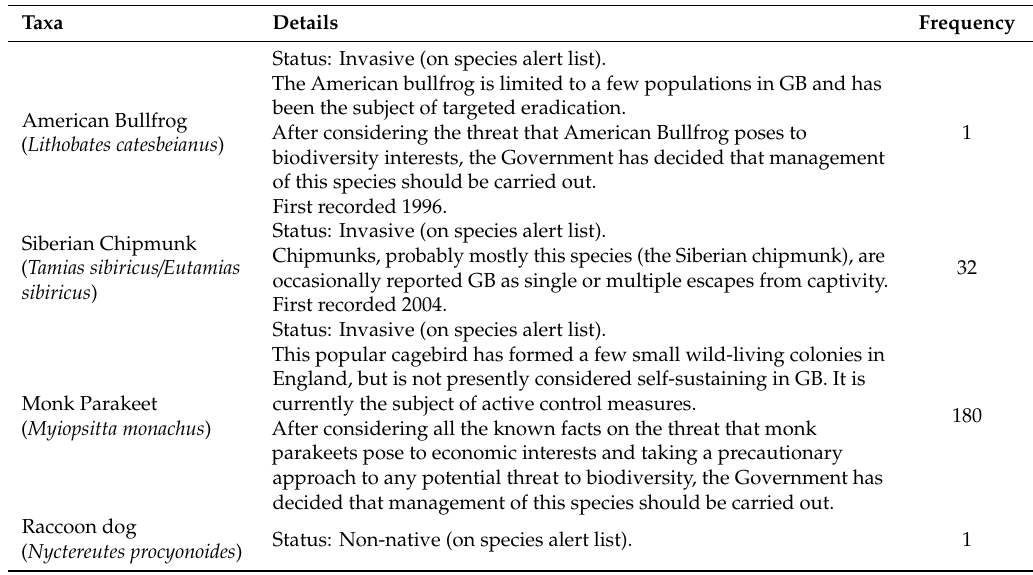
Table A5. Species on the GB Non-native secretariat 2020 Species alert list: http: // www.nonnativespecies. org / alerts / index.cfm. Frequency refers to the frequency of listings of descriptive terms relating to the specific species.